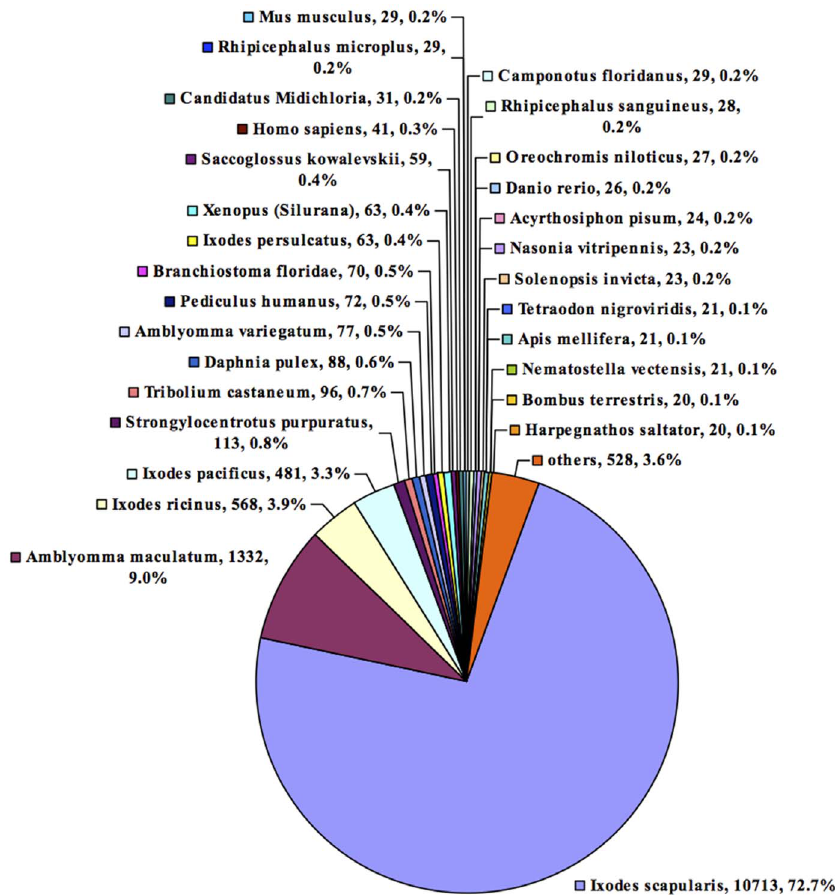
Figure 2. Percentage similarity distribution of transcripts expressed in B. henselae -infected and non-infected I. ricinus female salivary glands, from the top hit in the protein database.